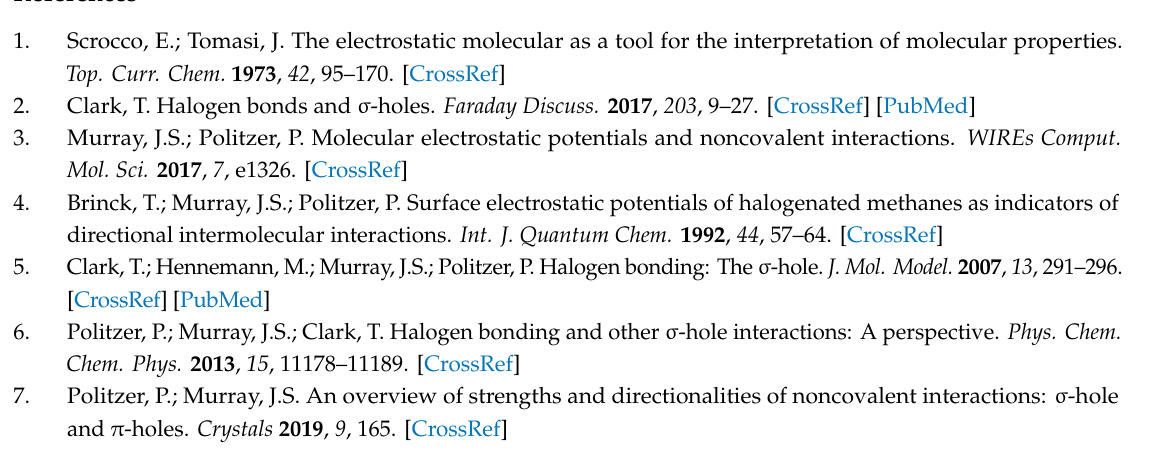
Supplementary Materials: The following are available online. Table S1: Energies and structural properties of low energy optimized (B3LYP / 6-311G*) conformers of compounds 1 – 6 , Figure S1: V S representations on electron density isosurfaces (0.002 au) for conformers of compounds 2 , 3 , and 5 , Figure S2: Se ··· N ChB in crystal packing of conformer 5 -B2 (CCDC no. 1963860), Table S2: V S,max calculated for conformer 6-B1 with di ff erent method / basis set, Figure S3: Linear correlation between σ - and π -holes calculated with di ff erent methods / basis set, Table S3: Energies and structural properties of low energy optimized B3LYP / 6-311G* conformers of compound 7 , Table S4: V S,max on halogen (Cl, Br) and π -holes calculated for conformers 7 -A1, 7 -A2, 7 -B1, and 7 -B2, Table S5: V S,max and their Source Function (SF) atomic group contributions on external and internal π -holes calculated for the various conformers of systems 2 – 3 and 5 – 6, Table S6: V S,max variations ( ∆ V S,max ) of C pyridyl –Ch and C R –Ch (Ch = S, Se) σ -holes and corresponding Source Function (SF) contributions changes ( ∆ SF) upon substitution of Ch or R atom / group or of both of them for a given conformer of systems 1 – 6 , Table S7: ∆ V S,max and their ∆ SF atomic group contributions on C pyridyl –Ch and on C R –Ch σ -holes calculated upon change of conformation for systems 1 – 6